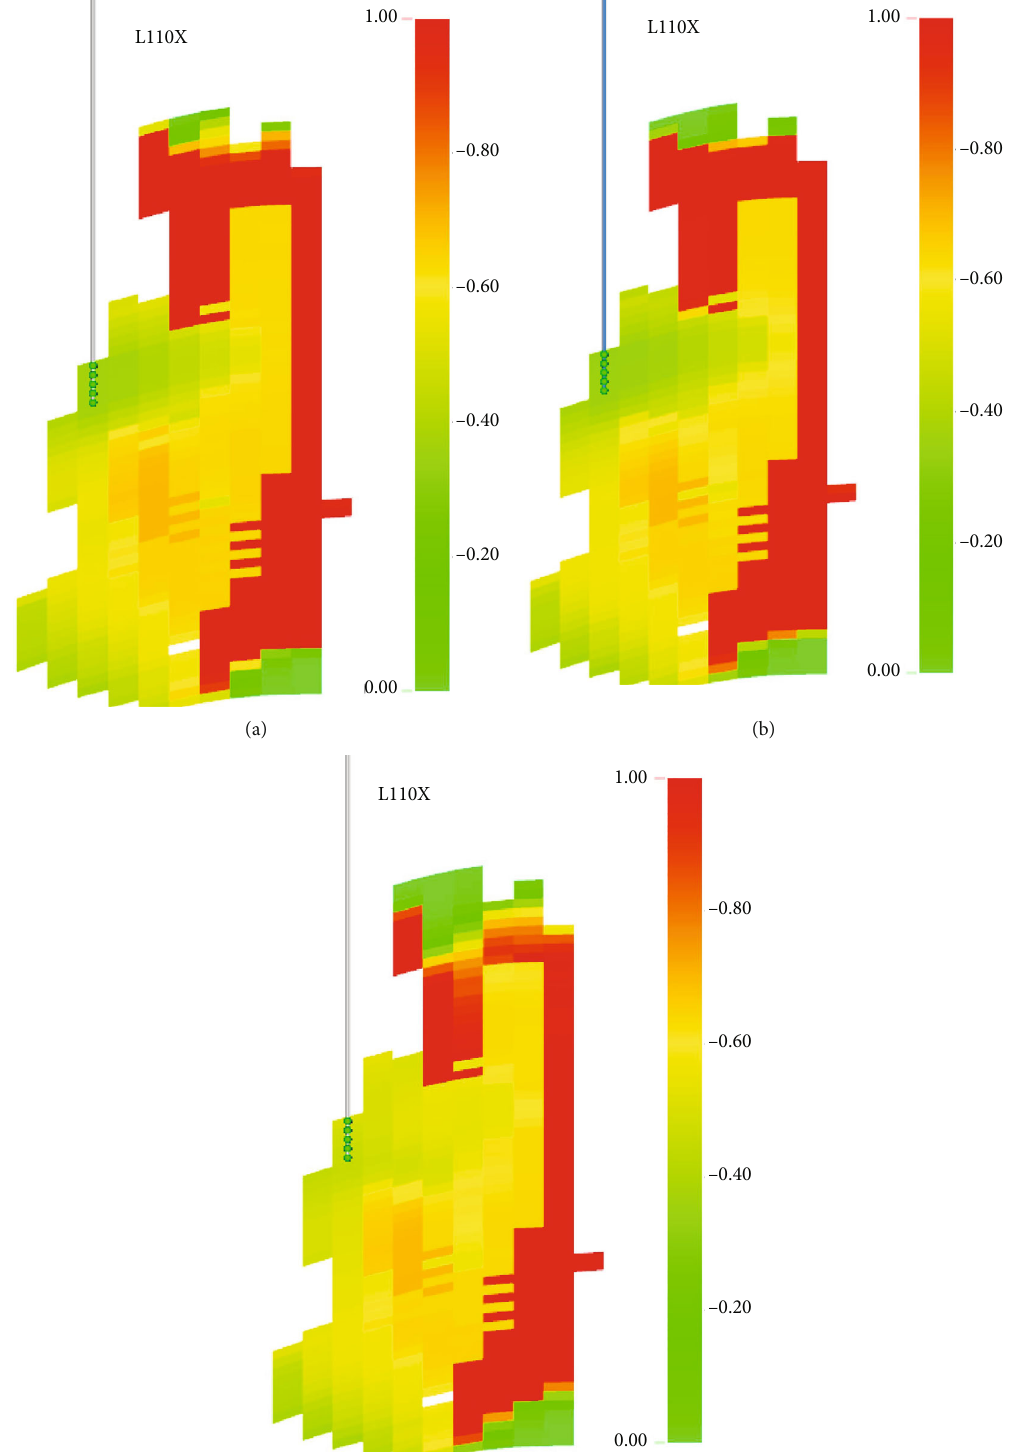
Figure 17: In fl uence of gas injection development on oil-water distribution characteristics of the L110X